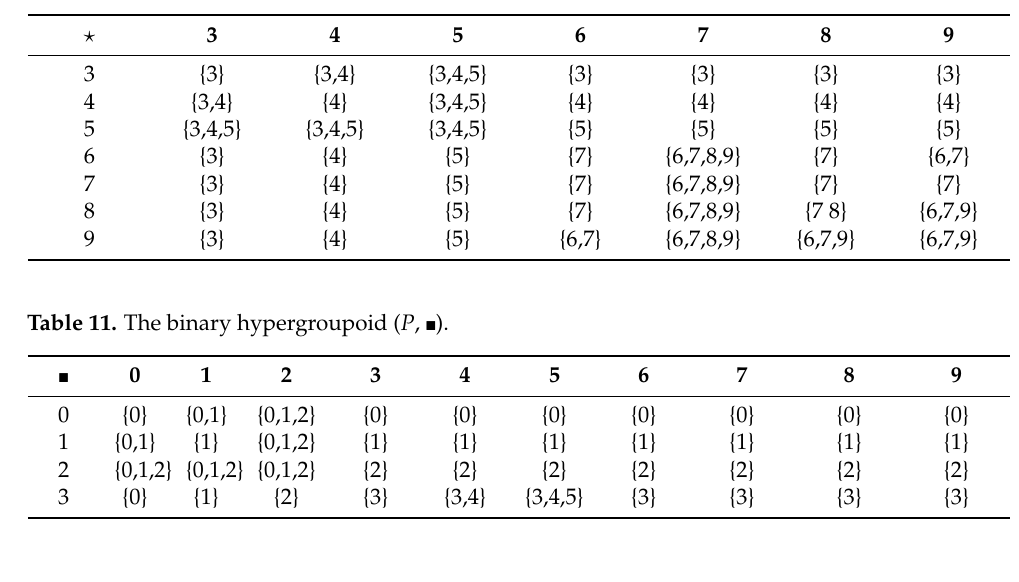
Table 10. The binary hypergroupoid ( M , (cid:63) ).